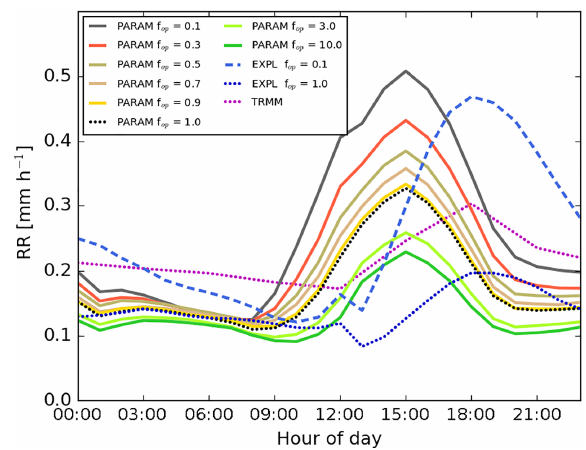
Figure 5. Diurnal cycle of precipitation averaged over the DAC- CIWA box and for July 2006. Solid lines show PARAM simulations for varying f op , and the dashed line shows the EXPL simulation for f op = 0 . 1. Dotted lines denote PARAM and EXPL simulations with f op = 1 . 0 and additionally TRMM